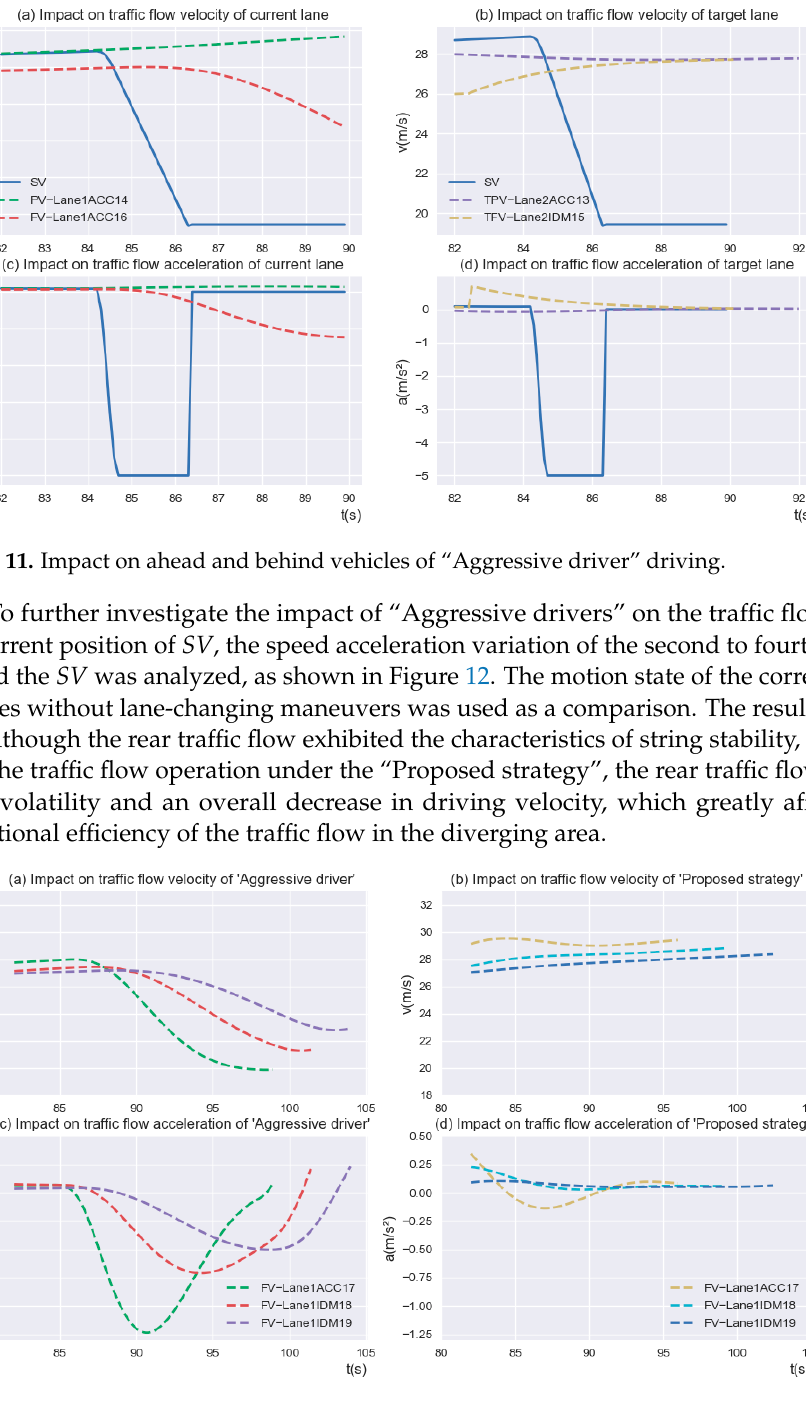
Figure 12. Impact on traffic flow operation of “Aggressive driver” and “Proposed strategy”. On the contrary, the proposed strategy can predict and avoid the unsuccessful lane change dilemma encountered by “Aggressive drivers” in advance and execute the opti- mal strategy among the generated feasible strategies. In Table 2, seven sets of randomized experiments (ST1–ST7) and the travel time of SVs with the proposed strategy (Opt ST) in DIA are shown, and the results show that the proposed strategy can significantly improve the single-vehicle travel efficiency of SVs. Assuming that the desired speed of vehicle pas- sage is 100 km/h and the desired travel time is 36 s, then the lost time of travel through the DIA for each strategy can be obtained, as shown in Figure 13. From the figure, the average travel loss time of the random lane change strategy is about 7 s, and the travel time of the optimal strategy is 2.5 s. The SV can reduce the loss time of traveling by more than 60% by following the proposed strategy. Table 2. Travel time through the DIA of different strategies for SV. Driving Strategy